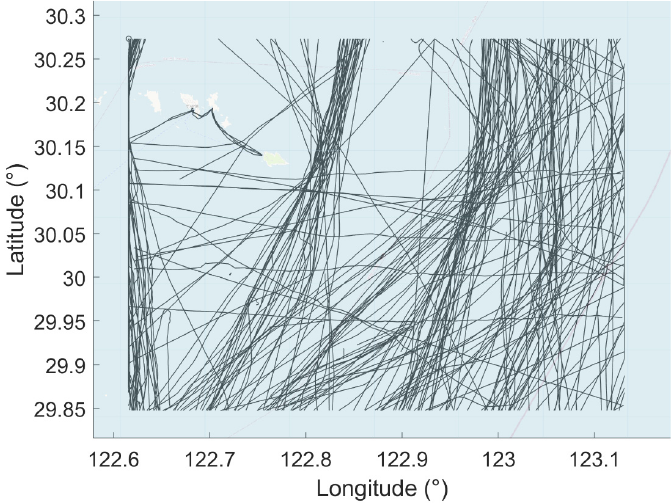
Figure 5. Ship trajectories in the research area at 8 AM 7th to 8 AM 8th March 2018.